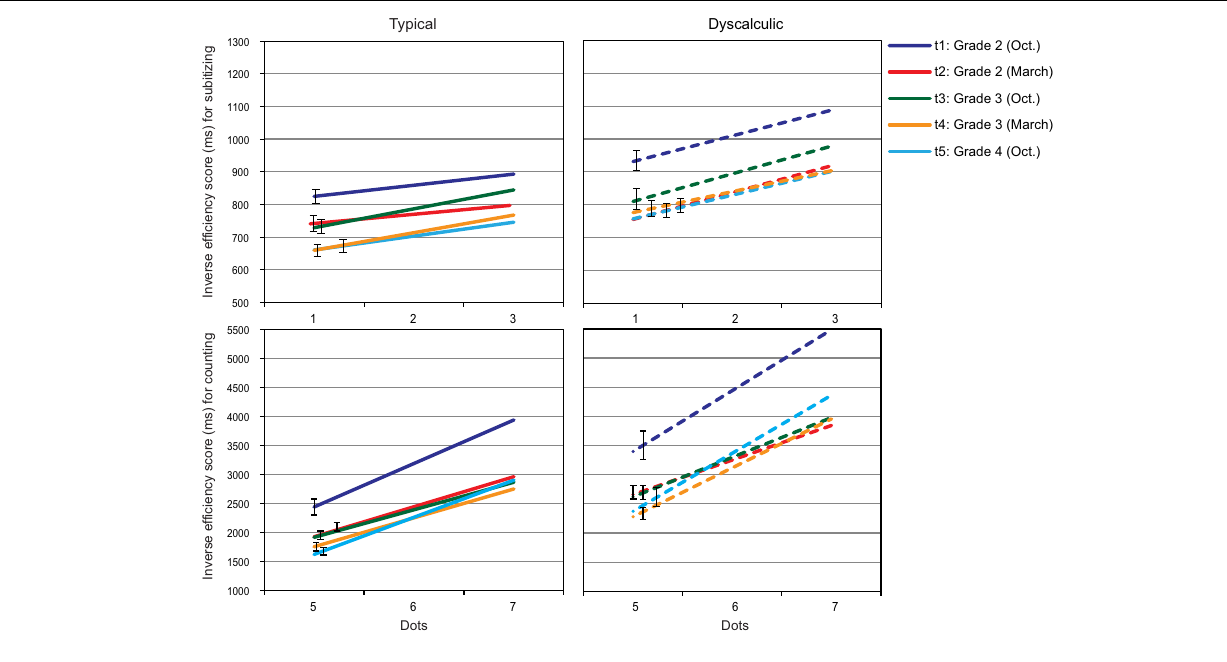
FIGURE 3 | Dot enumeration: Regression lines for IE-scores in the subitizing range (top) and the counting range (bottom) across five assessment points (error bars represent SEs of intercepts).